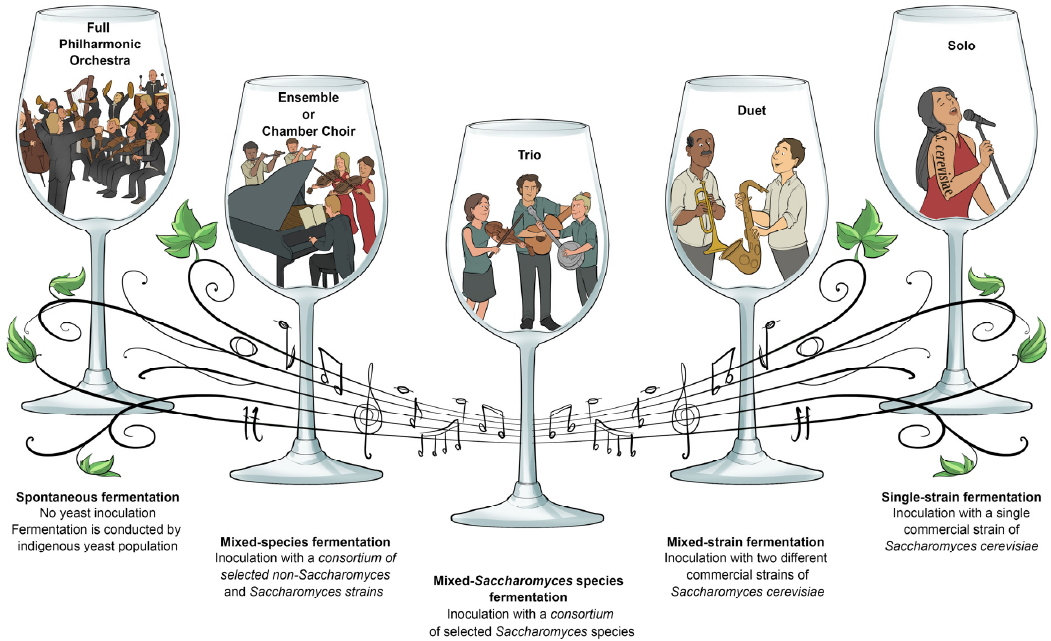
Figure 10. The diverse array of approaches to yeast fermentation in the production of wine. In spontaneous ferments, winemakers depend entirely on ambient yeast originating from the vineyard and winery to ferment grape sugars to ‘dryness’. With ‘inoculated’ ferments, winemakers can choose to conduct the yeast ferment with mixed species (which can include species from either Saccharomyces or non ‐ Saccharomyces species, or both), mixed strains (different strains of S. cerevisiae ), or with a single strain (a selected S. cerevisiae strain) to craft a specific wine style.